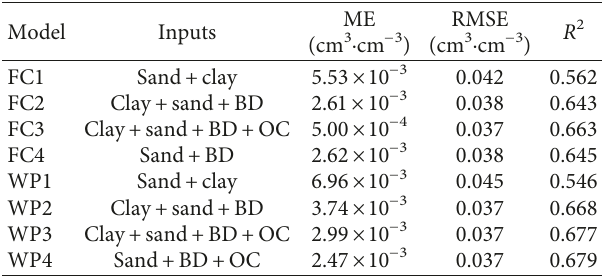
Table 6: Performance indicators for SVR models with different